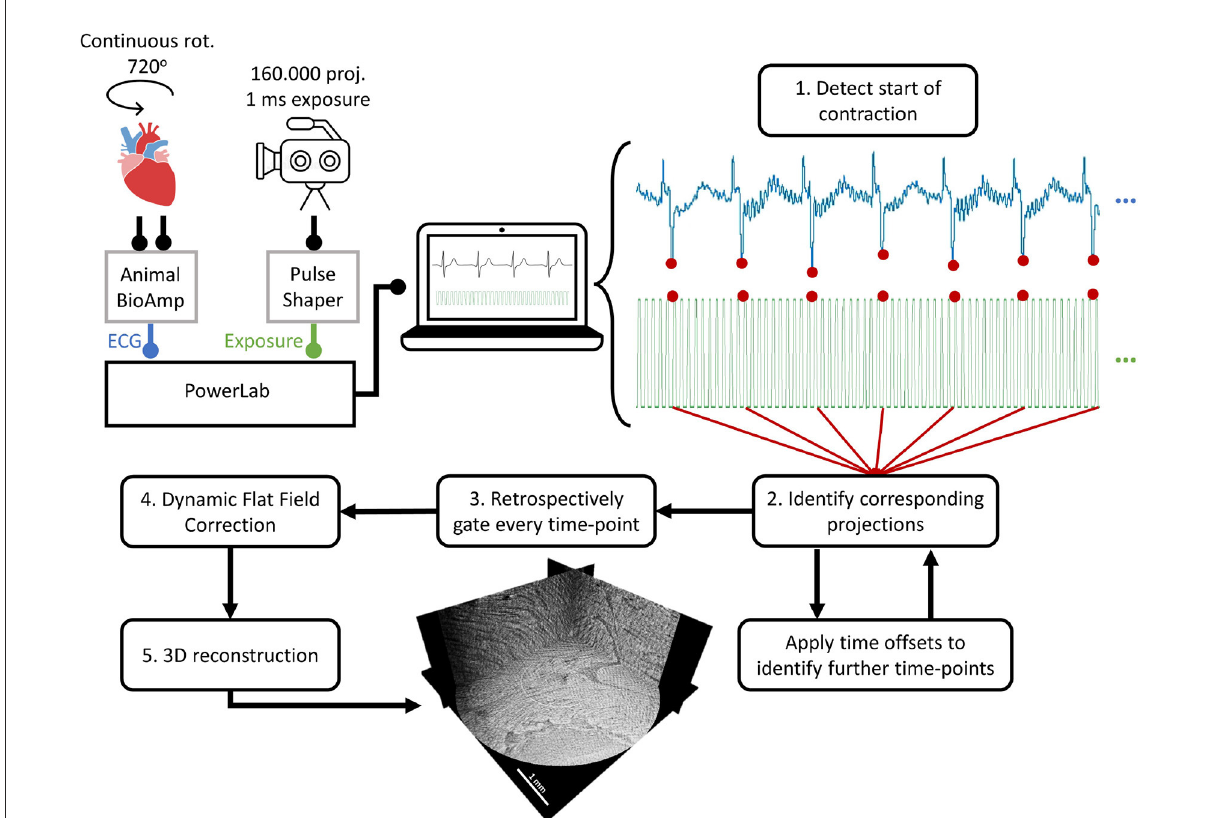
FIGURE2 Sketch of the retrospective gating procedure. In dynamic scans, 160,000 projections (1 ms exposure) were acquired over 720 o of continuous rotation. The ECG of the beating heart was recorded by the PowerLab through an Animal BioAmp. Simultaneously, the exposure signal from the detector was sent through a pulse shaper to the PowerLab. For the retrospective gating, (1) the feature corresponding to the start of the contraction was detected in the ECG. (2) Then, all the corresponding projections acquired at that specific time-point were identified. To identify the projections in the rest of time-points, 1 ms offsets were applied until the time-series were completed. (3) With all projections assigned to each time-point, the data was gated and all individual datasets for every time-point were created. (4) All datasets were corrected using dynamic flat-field correction and (5) reconstructed to obtain the 3D volumes for every time-point in the